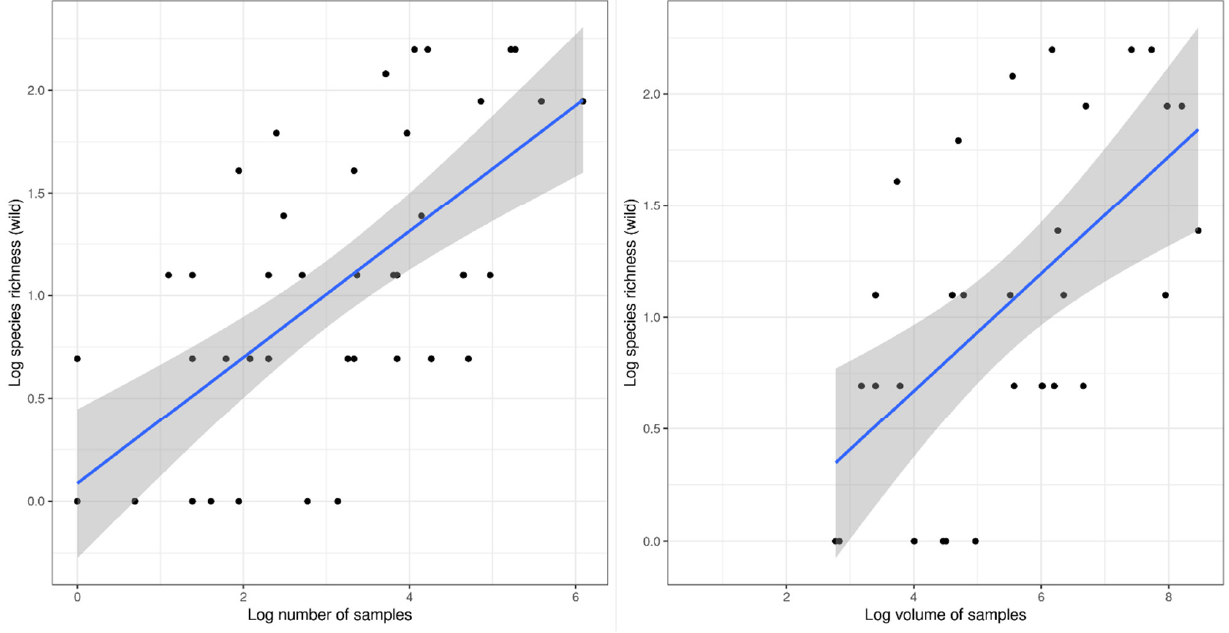
Figure 3. Correlation analysis of number (left) and volume (right) of samples to wild species assemblage richness, using log-normalised values.